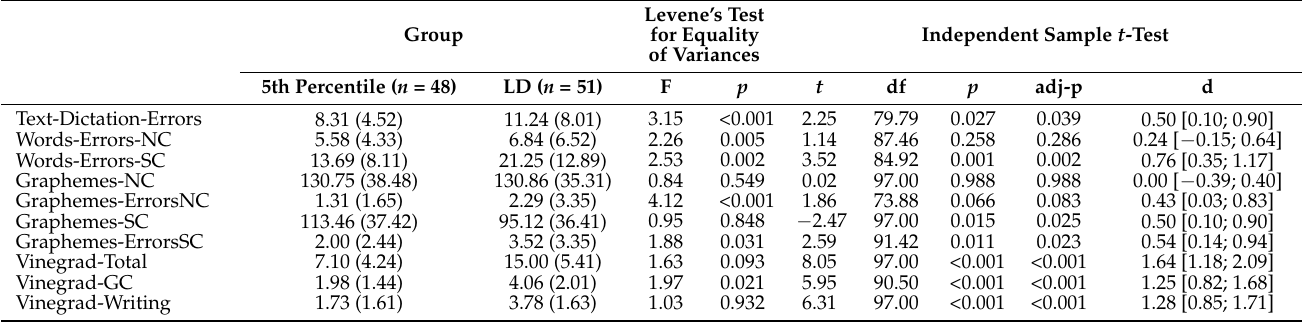
Independent Sample t